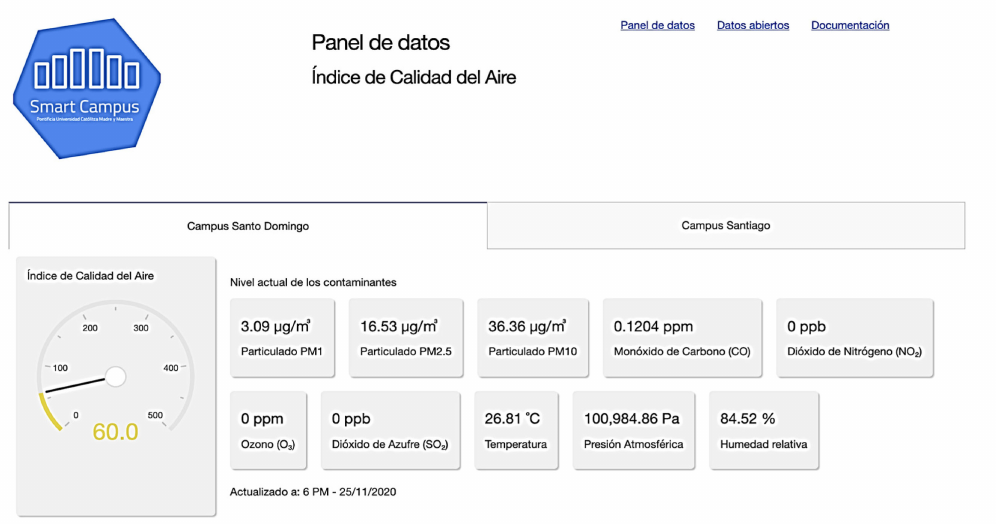
Figure 4. View of the Air Quality Dashboard, the last measurement section.